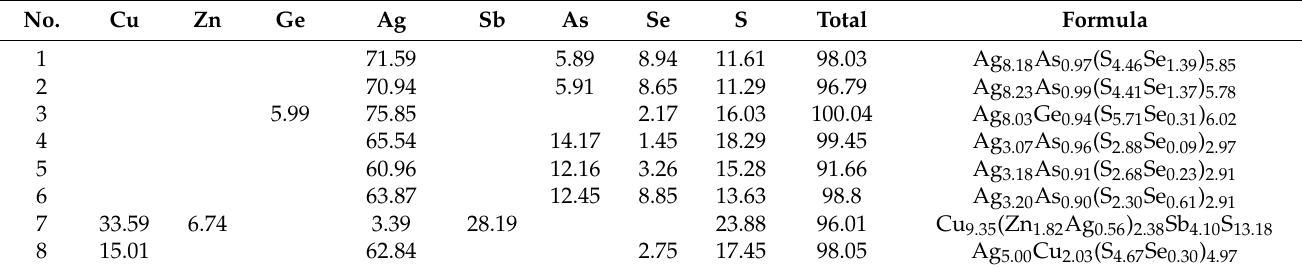
Table 7. Composition of subordinate ore minerals from the Rodnikovoe deposit,